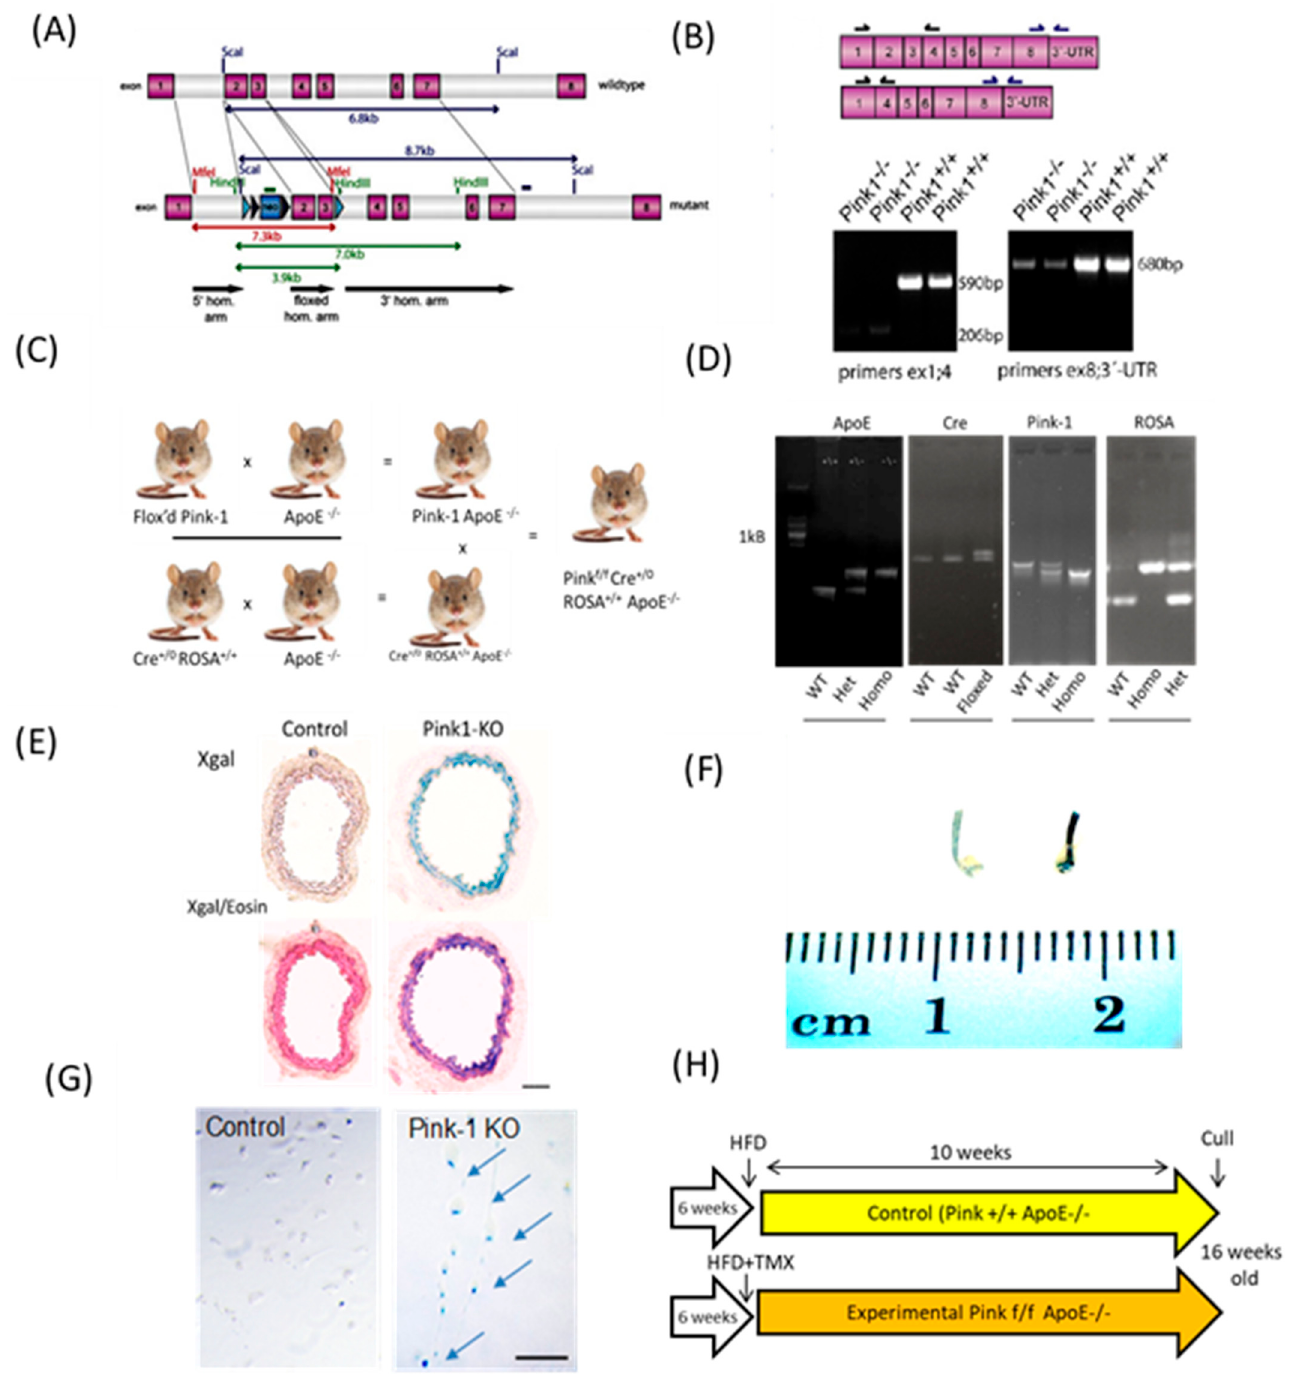
Figure 1. Mice breeding scheme. ( A ) Original Pink1 f/f knockout out mice locus and ( B ) truncation site and original Southern blot by Glasl et al [15]. ( C ) Flox’d Pink1 f/f mice were crossed with ApoE − / − animals. Double homozygotes were then bred with Cre +/0 Rosa +/+ ApoE − / − mice. ( D ) DNA genotyping for each allele ( E ) Pink excision pilot study used a Cre/ROSA beta galactosidase reporter after IP injection with tamoxifen in corn oil (n = 3). Cre-recombinase and X-gal staining was confirmed across entire sections of aortic rings (upper pair) of vessels and is counterstained with eosin (lower pair). ( F ) Whole abdominal aortic tissue were stained blue in presence of X-gal when Pink was excised and Cre was activated. ( G ) A Pink1-KO VSMC line was derived from Pink f/f explant whole aortae and treatedwith hydroxytamoxifen (OHT) in culture to mediate Pink1 excision using a beta-galactosidase reporter (arrows) (×10) (scale bar 100 µm). ( H ) The atherosclerosis feeding protocol included littermate and sex-matched controls with groups fed up to 16 weeks of age to generate atherosclerotic lesions.